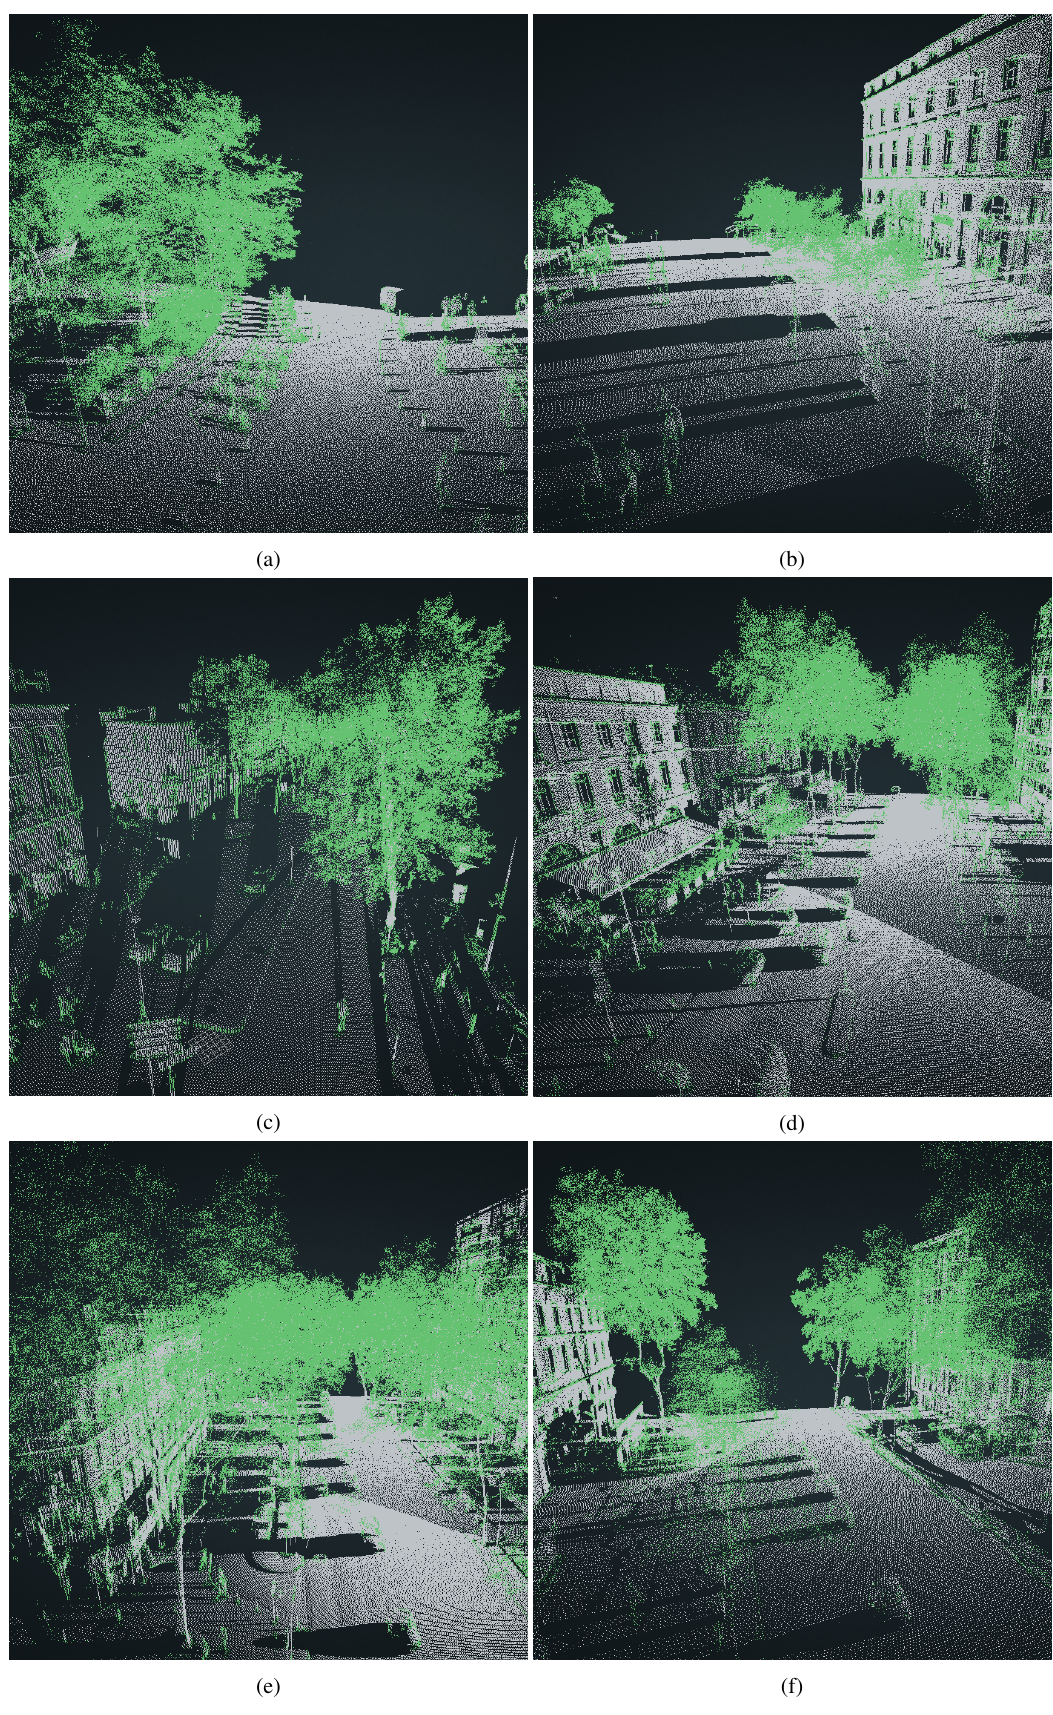
Figure 4: The classification results of six point clouds acquired by mobile mapping